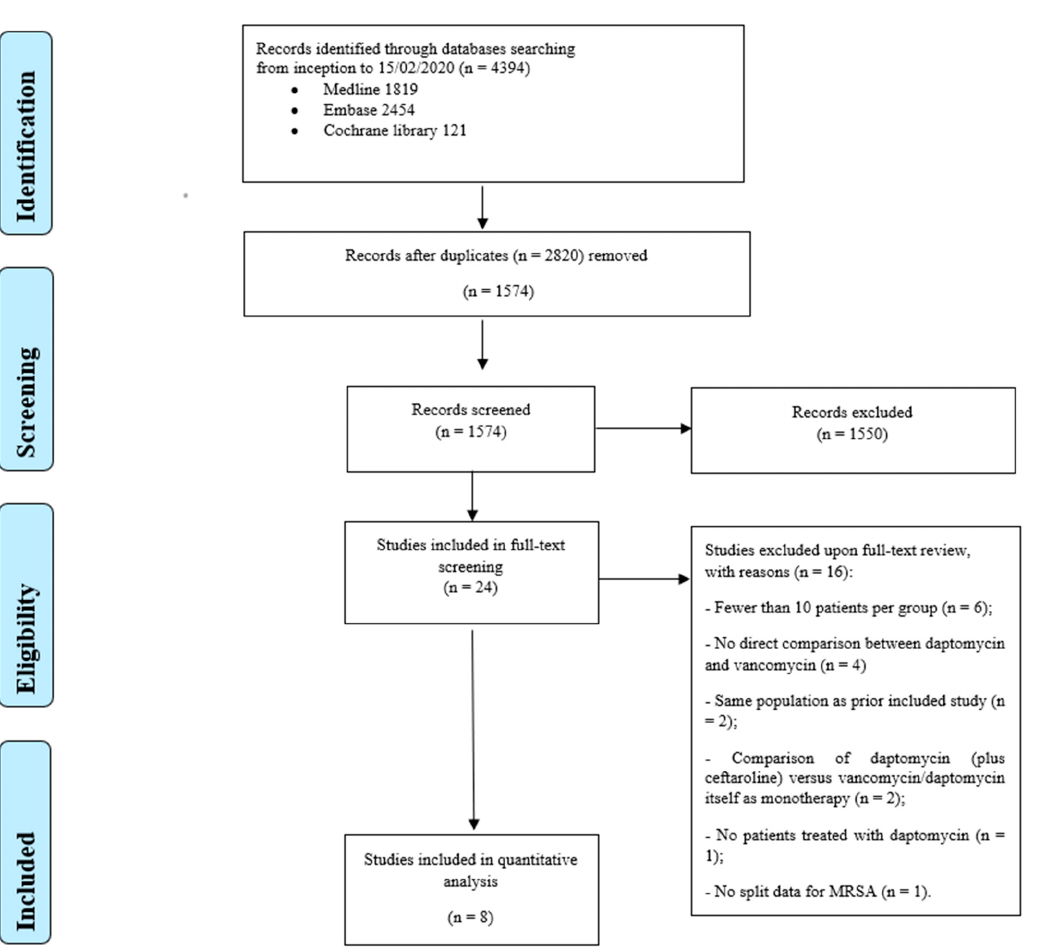
Figure 1. Results of literature search and flow diagram for selection of eligible studies.